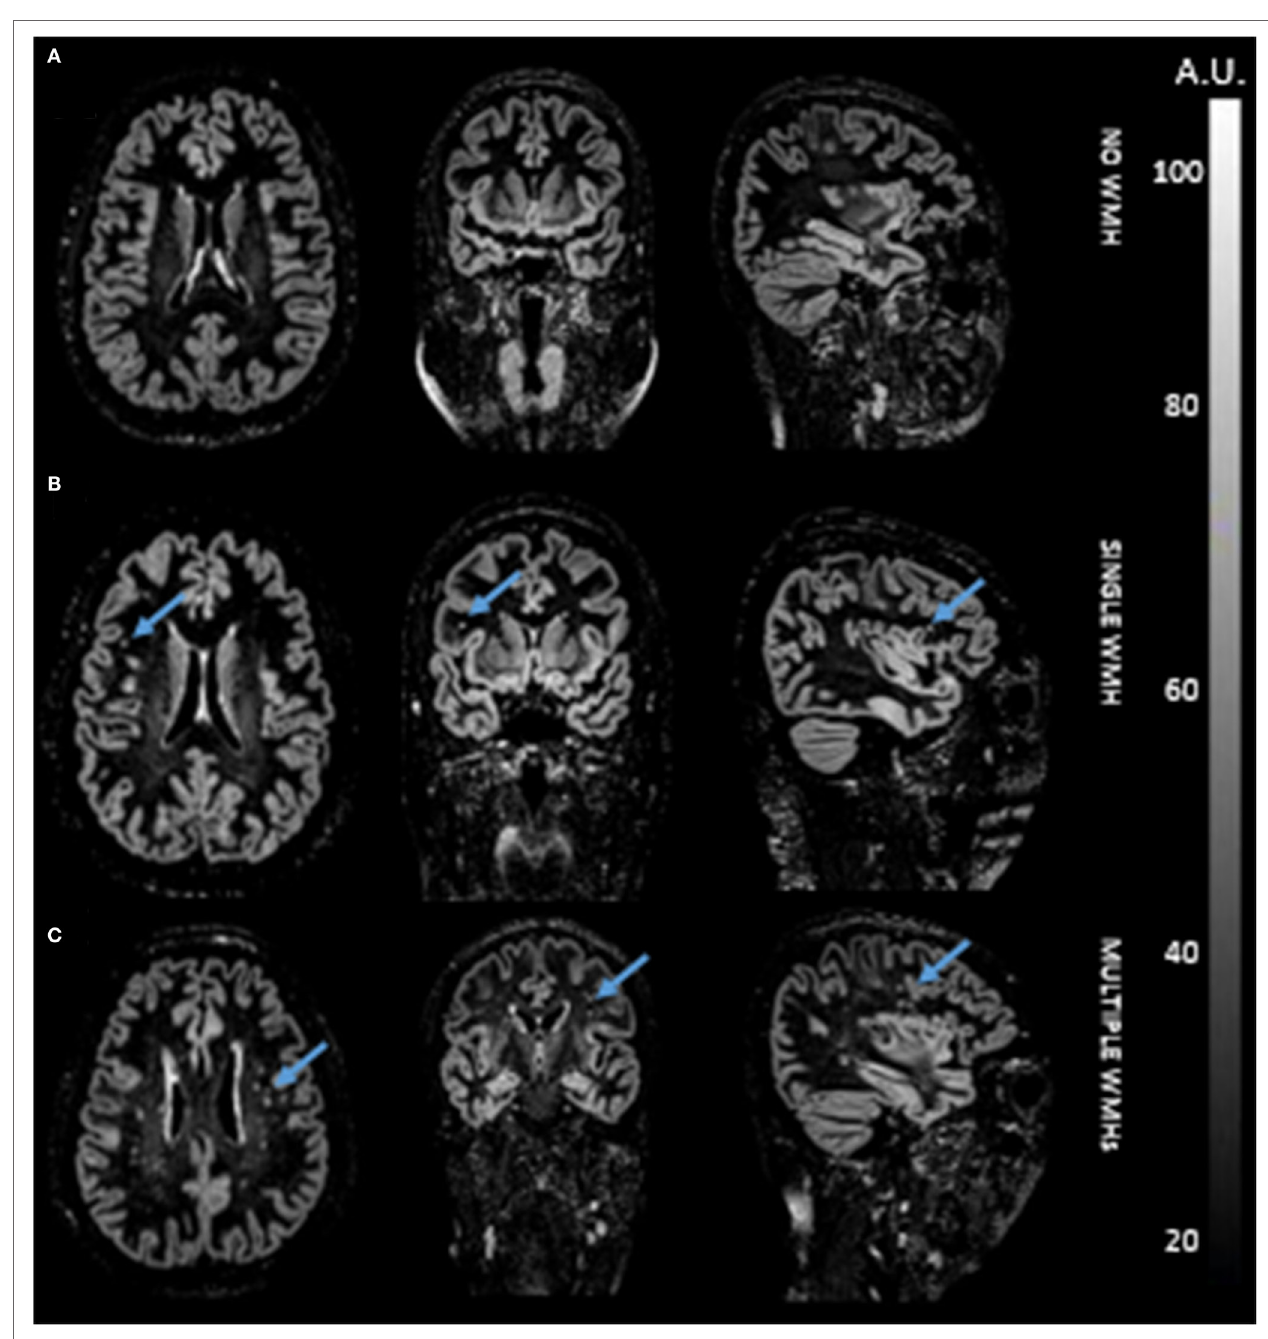
FigUre 3 | Double inversion recovery images of three representative participants without white matter hyperintensity (WMH) (a) , with single WMH (B) , and with multiple WMHs (c)